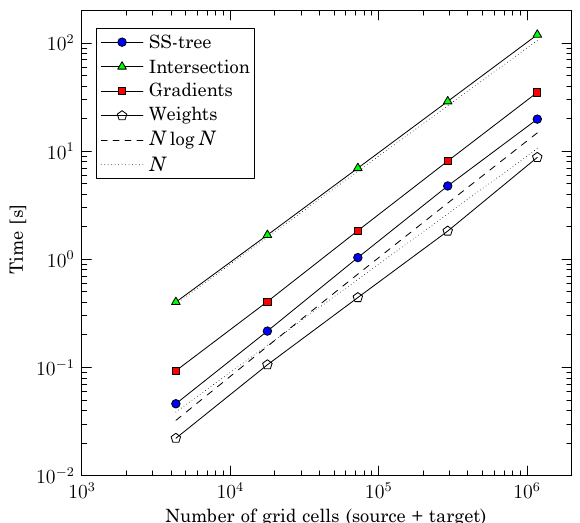
Figure 7. Timing of the various steps of second-order remapping from a uniform resolution icosahedral–hexagonal mesh to a reg- ular latitude–longitude mesh. The SS tree construction shows the expected O(N log N)